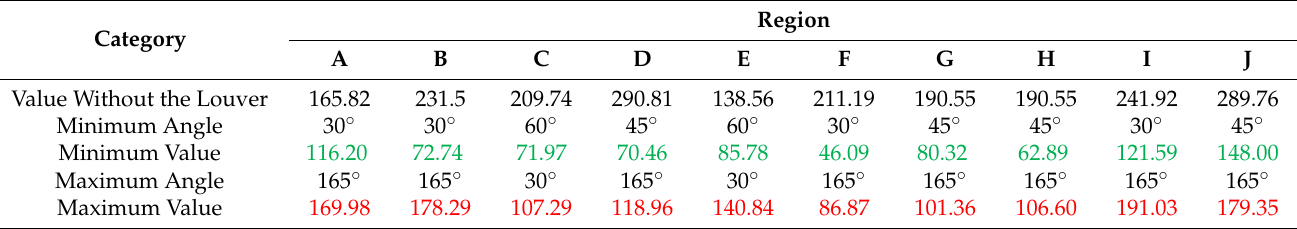
Table 5. Total thermal energy consumption in